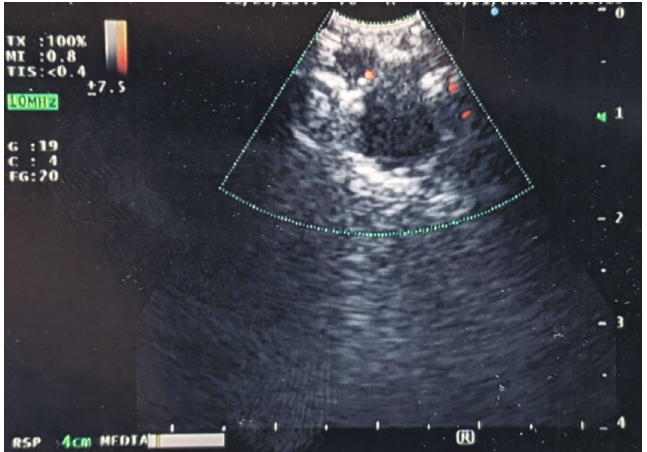
Figure 3: Bronchoscopy with EBUS showing an enlarged right hilar nodule.